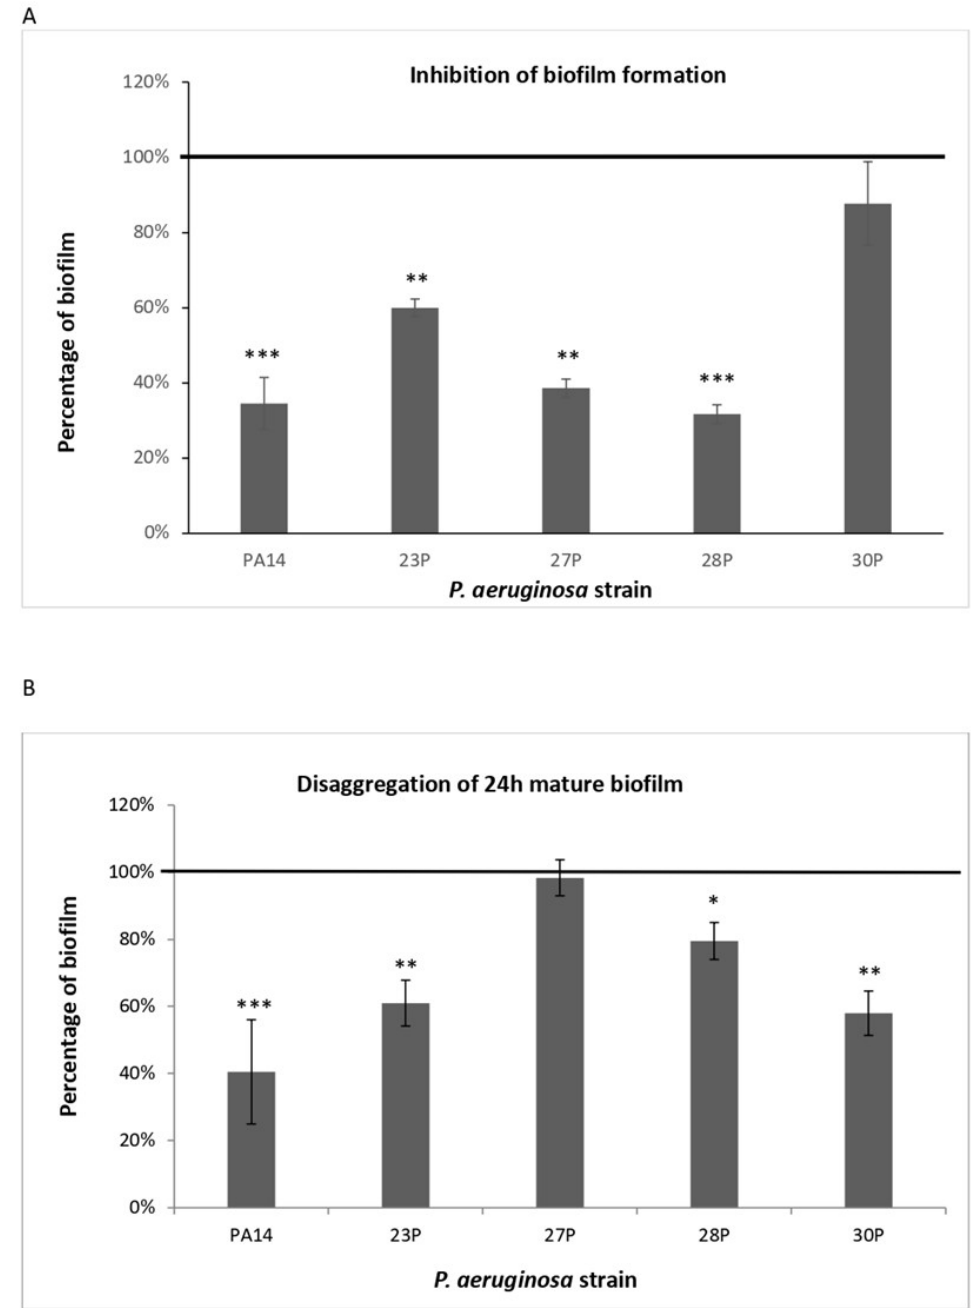
Figure 2. Effect of SPEP on biofilm formation of different clinical and reference strains. Panel ( A ): Effect of SPEP on biofilm formation. In the ordinate axis is reported the percentage of bacterial biofilm production. Data are expressed as the percentage of biofilm formed in presence of 200 U/mL SPEP compared with the untreated bacteria. Each data point is composed of 4 independent experiments, each performed at least in 3 replicates. Panel ( B ): Effect of SPEP on a 24 h mature biofilm. In the ordinate axis is reported the percentage of residual biofilm. Data are expressed as the percentage of residual biofilm after 24 h of treatment compared with the control sample. Each data point is composed of 4 independent experiments, each performed at least in 3 replicates. Error bars indicate the standard deviations of all the measurements. Statistical differences were determined by the Student’s t -test: * p < 0.05; ** p < 0.01, *** p < 0.001, compared with the control.